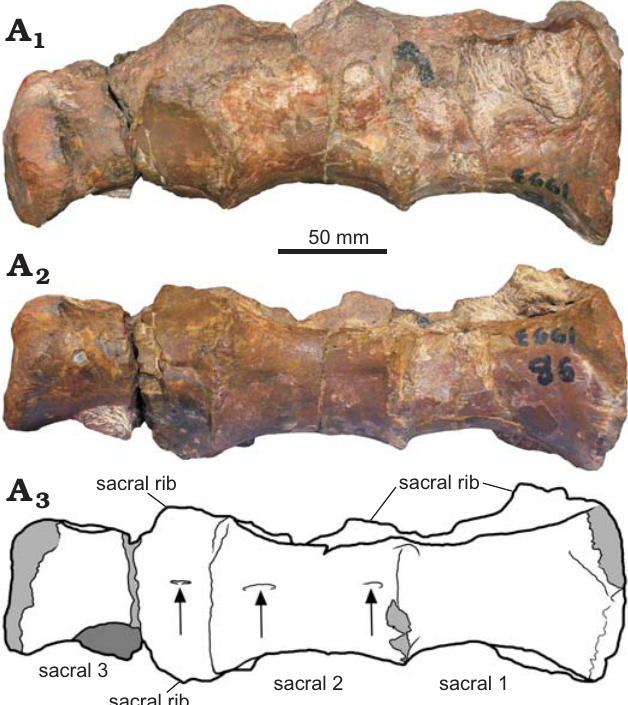
Fig. 4. Coelurosaurian theropod Phuwiangvenator yaemniyomi gen. et sp. nov. from the Early Creta ceous Sao Khua Formation of Phu Wiang, Khon Kaen Province, Thailand. SM-PW9B-39, anterior sacral vertebrae in right lateral (A 1 ) and ventral (A 2 ) views; line drawing in ventral view (A 3 ). Arrows indicate ventral sulci, light grey, broken part; dark grey, matrix.